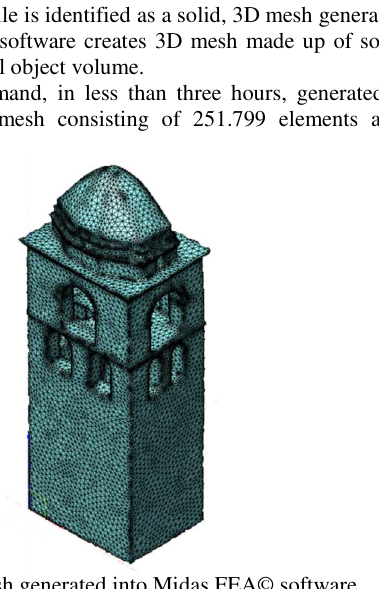
Figure 9 - Mesh generated into Midas FEA© software